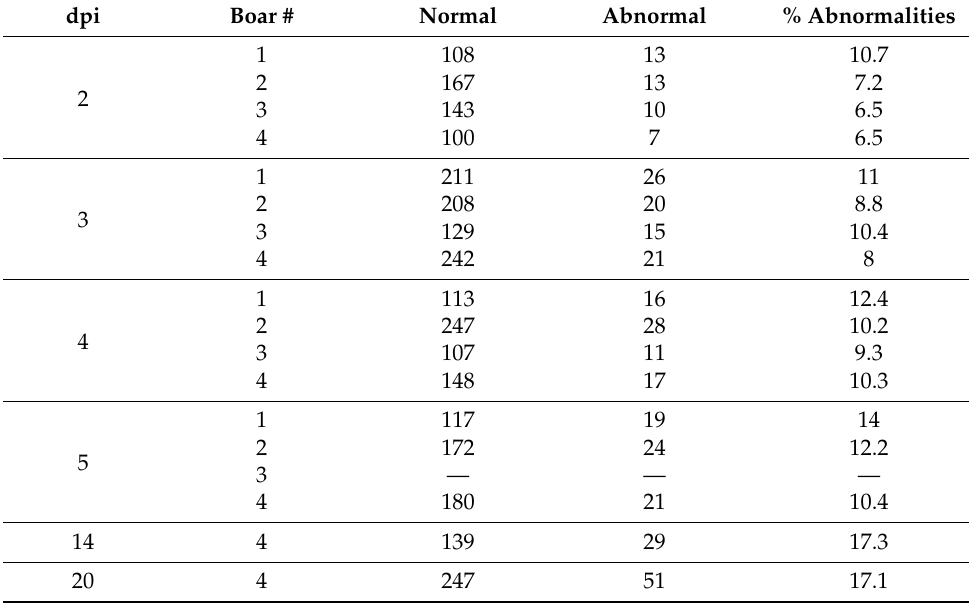
Table 4. Total numbers of spermatozoa counted and proportions of normal and abnormal spermato- zoa observed in each ejaculate after inoculation with ASFV. dpi Boar #